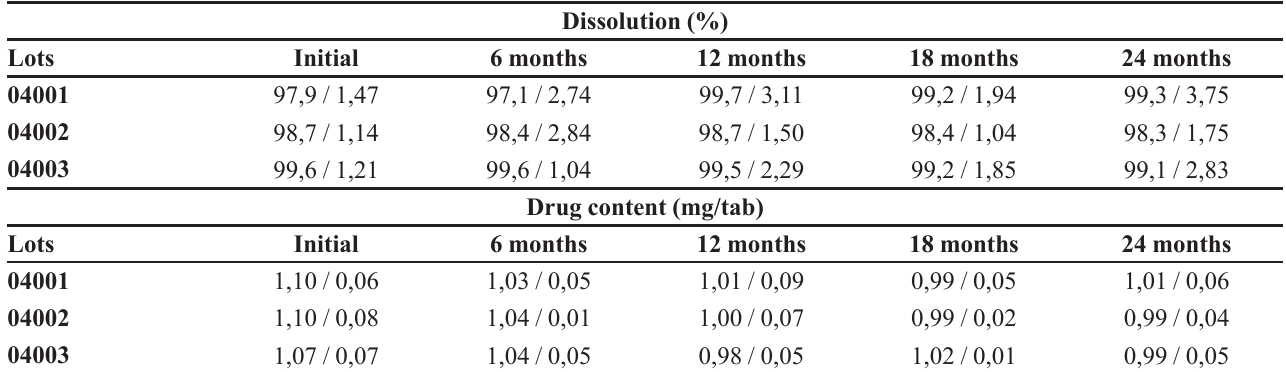
TABLE III - Analytic results of the lots under long-term stability conditions